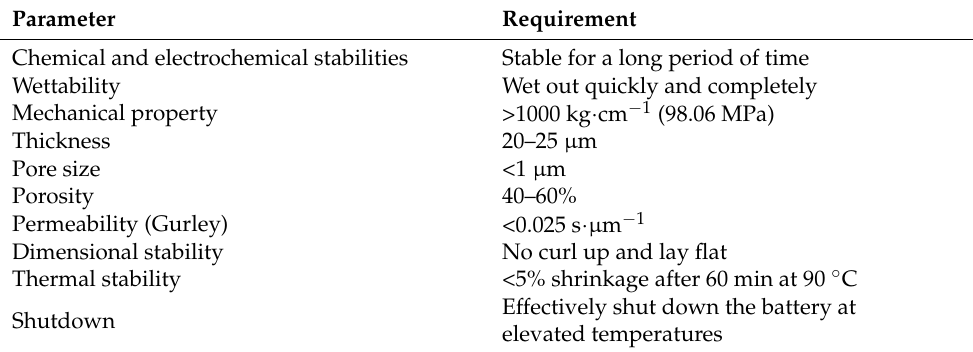
Figure 1. Schematic image of a separator in cylindrical Li-ion battery cell and a zoomed-in cross- section of the layered structure. Table 1. General requirements for separators used in Li-ion batteries